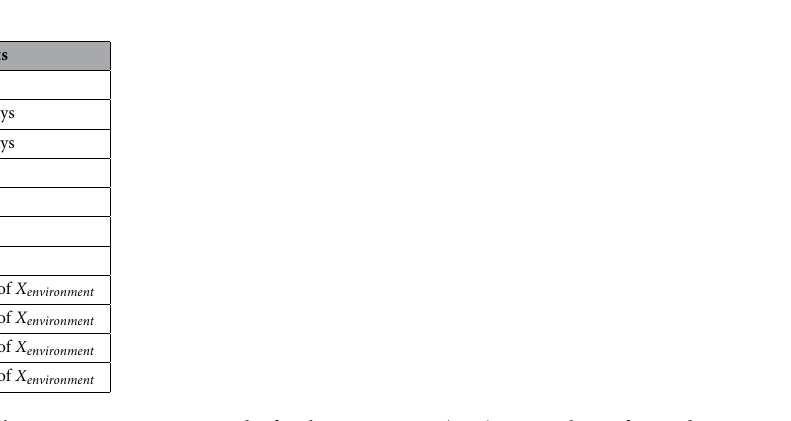
Figure 8. ( a ) Objective function’s convergence result during the processing of the particle swarm algorithm applied for MCovidSim-2 ’s updating using real data from Passa Vinte (MG) city. ( b ) Real cumulative cases and deceased curves.